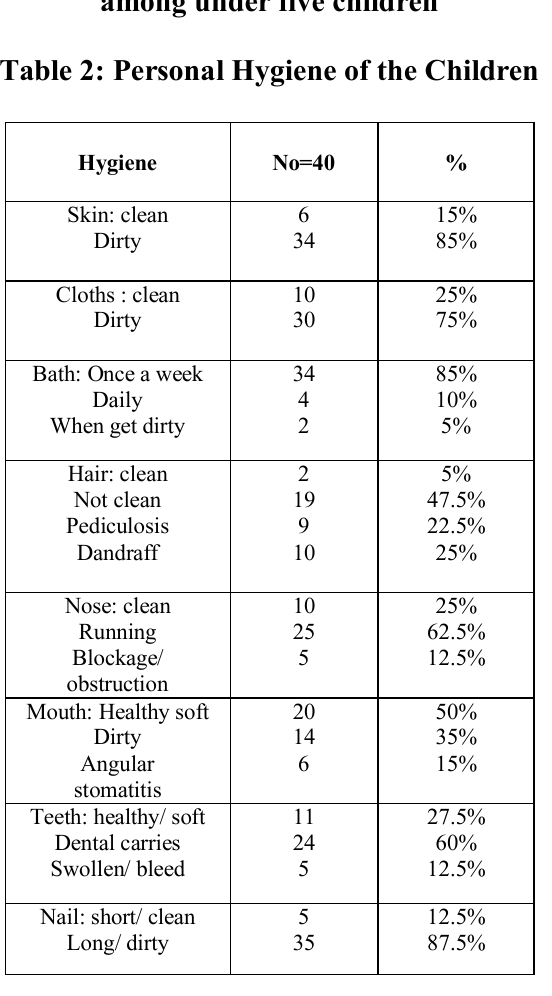
Table 2, depicted that majority of the children’s personal hygiene were poor.